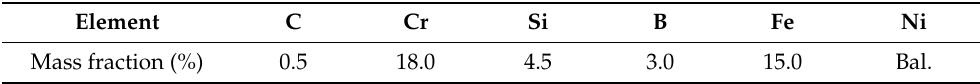
Table 1. Chemical composition of TC4 (Ti6Al4V alloy) powder. Table 2. Chemical composition of Ni60 powder.